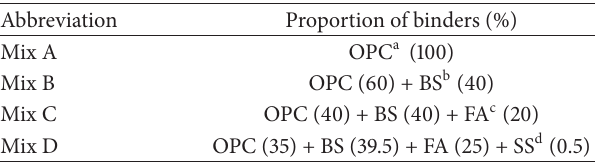
Figure5:Chemicalstructureofhalf-esterificationreactionproduct. Table 1: OPC and partial replacement ratio in each